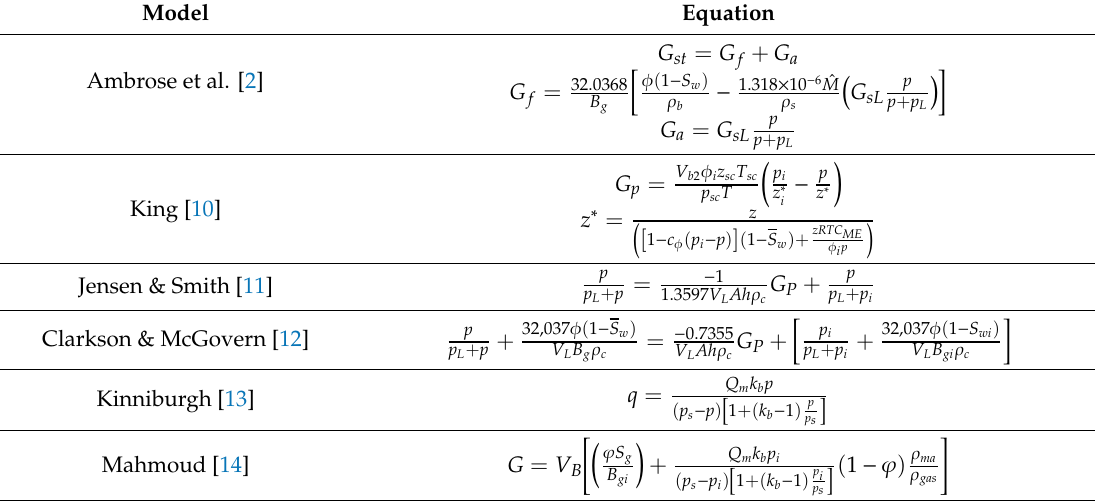
Table 1. Volumetric and Material Balance Equations MBE Models for Nanopores of Source